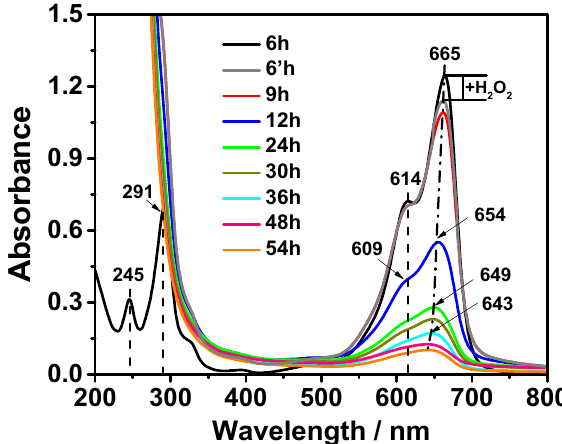
Figure 11. Temporal UV–Vis adsorption spectra of the MB solution during the degradation process in the Co–SiO 2 (0.17) and the H 2 O 2 system.